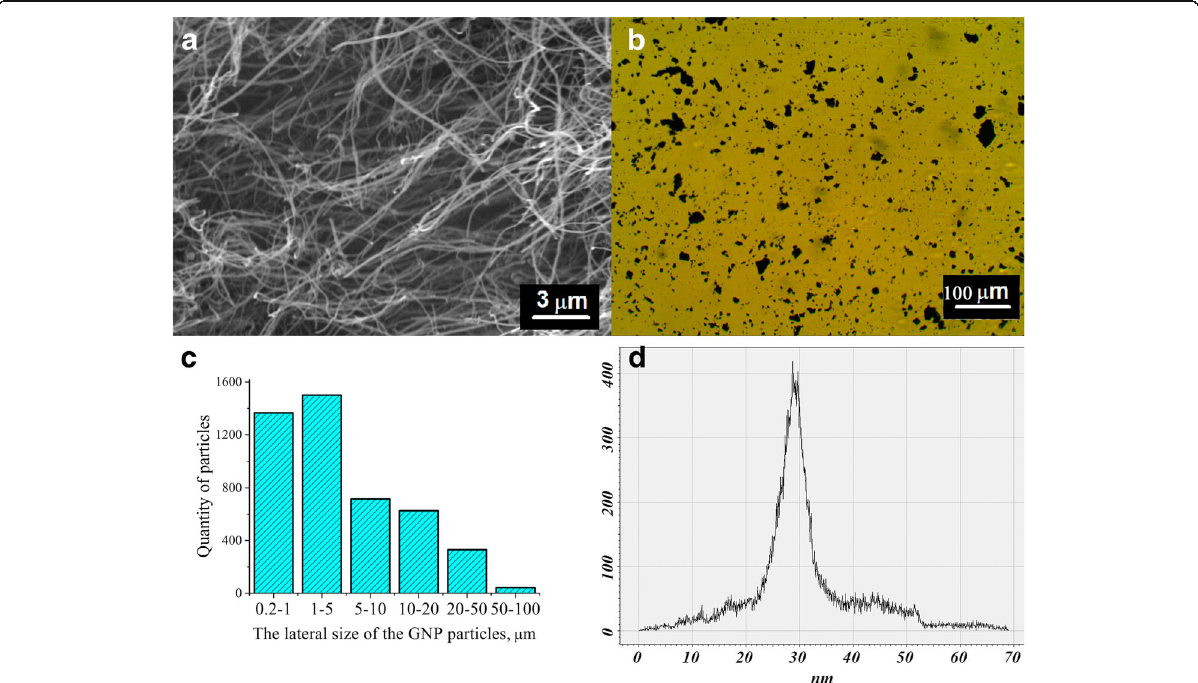
Fig. 1 SEM images for the MWCNT ( a ). Optical image for the GNP ( b ). The distributions of particles (diagram) on the lateral size of TEG after 30 h